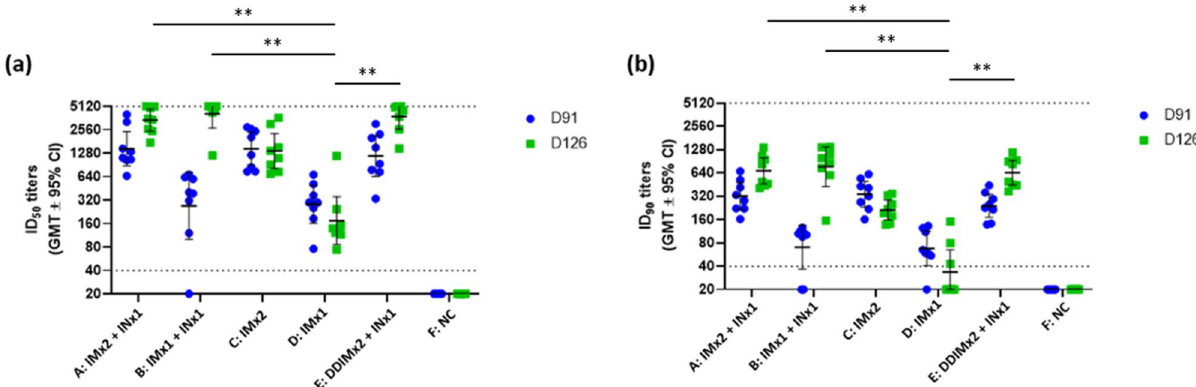
Figure 2. Induction of neutralizing antibodies in hamsters at 91 and 126 days after first immunization. Hamsters (N = 8 for group A–E and N = 6 for group F) were immunized once (groups B and D), or twice (groups A, C and E) at three weeks apart for intramuscular immunization. Groups A, B and E were boosted by single intranasal immunization at the end of 12 weeks post last IM immunization. Serum samples were taken for immunogenicity assays at 91 and 126 days after the first immunization. The antisera were subjected to neutralization assay with pseudovirus expressing SARS-CoV-2 spike protein to determine the ID 50 (left) and ID 90 (right) titers of neutralization antibodies. Each dot represents the serum sample neutralizing titer from each animal. Bars indicate geometric mean titers (GMT) and error bars indicate 95% confidence intervals. Dotted lines represent lower and upper limits of detection (40 and 5120, respectively, for both ID 50 and ID 90 ). Kruskal– Wallis with corrected Dunn’s multiple comparisons test and two-way ANOVA with Dunnett test for multiple comparison were used to calculate significance. * = p < 0.05, ** = p < 0.01, *** = p < 0.001, **** = p < 0.0001.